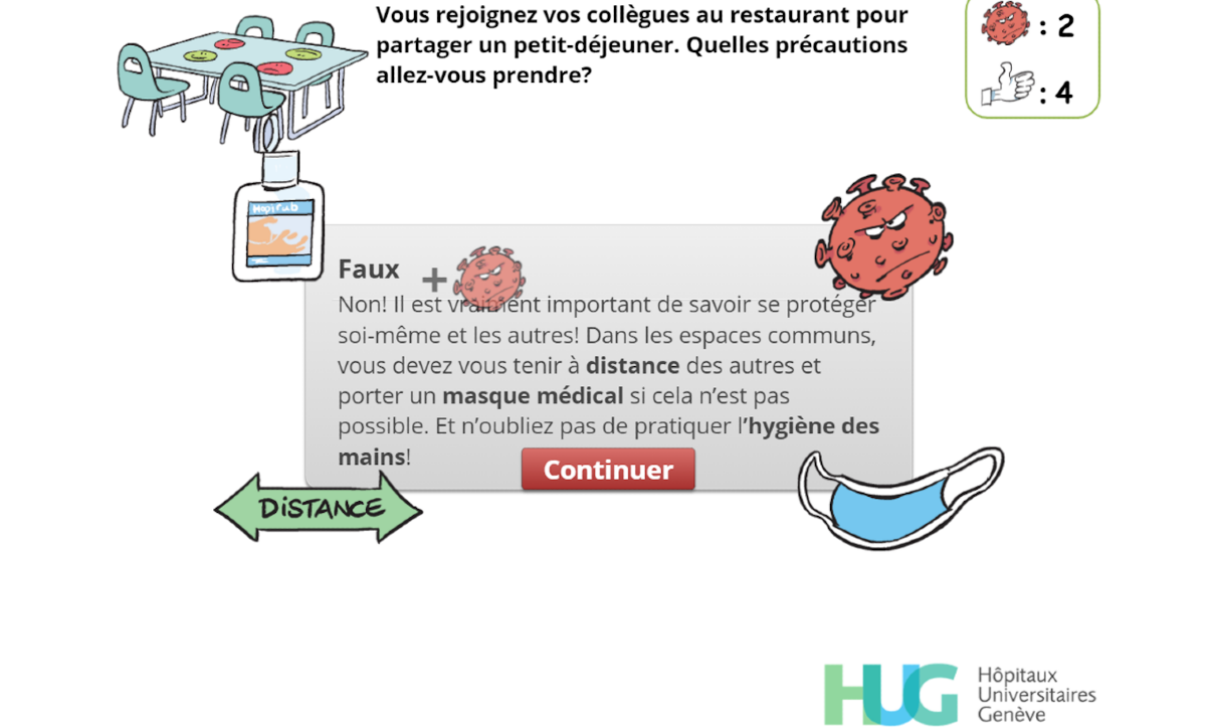
Figure 6. Feedback. The player has retried but has failed to identify the correct answers. Visual hints related to the correct answers are displayed (mask, distance arrow, alcohol-based handrub) and a short text emphasizes the expected answers, which will be displayed when the player clicks on continue (“Continuer”). A virus and a plus sign appear, rise, and progressively fade out before the virus count is updated.